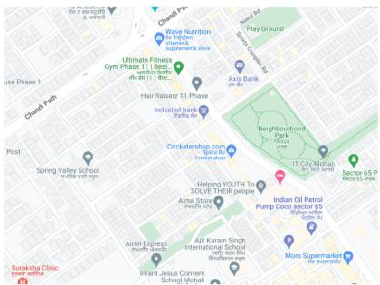
Figure 3. Google Maps Basemap Layer